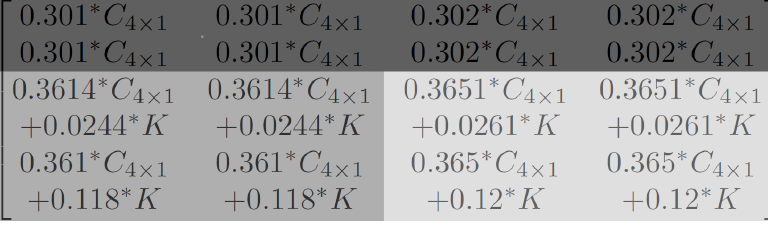
Figure 19. The 4 × 1 region after encoding and decoding, causing border